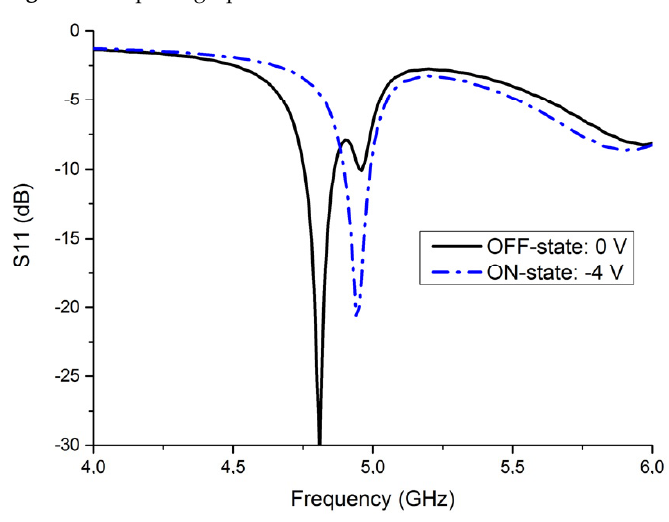
Figure 14. Measured results of the circular to linear polarization reconfigurable antenna. The radiation patterns of this antenna were measured in both states in an anechoic chamber. The measured results are presented in Figure 16a,b in the OFF state with a circular polarization and in the ON state with a linear polarization,